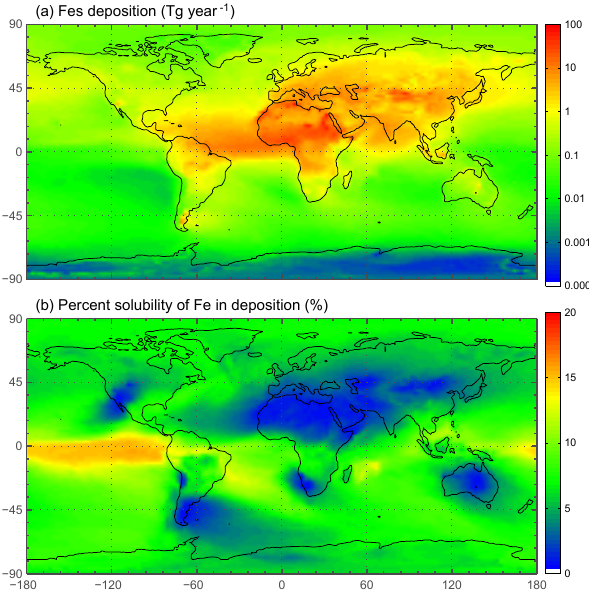
Figure 7. Spatial distribution of annually averaged soluble iron de- position from both dust and combustion in Tgyr − 1 (a) . Spatial dis- tribution of annually averaged fractional iron solubility from dust and combustion (%) (b)